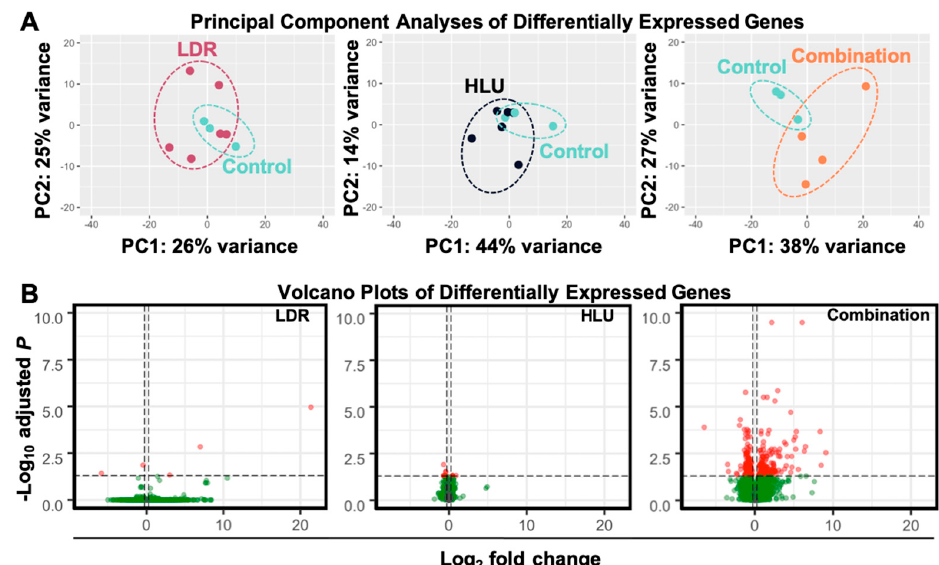
Figure 2. HLU in combination with LDR results in a heightened differentially expressed gene (DEG) profile in brains isolated at 4 months post-experimental conditions. DEG identified in brain isolated at 4 months post-LDR (0.04 Gy for 21 days), HLU (21 days) or combined HLU+LDR. ( A ) Principal component analysis (PCA) displays sample clustering within each experimental condition ( n = 3–6). ( B ) Volcano plots indicate DEG profiles at 4 months post-experimental conditions. Vertical dashed lines indicate the Log 2 fold-change cutoff used (0.263), while horizontal dashed lines indicate the adjusted p -value cutoff used (0.05). Red dots indicate differentially expressed genes that meet our adjusted p -value and Log 2 fold-change cutoffs and compose our set of differentially expressed genes. Green dots indicate genes that do not meet our adjusted p -value cutoff and, therefore, are not differentially expressed. Darker saturation of color represents overlap of genes.